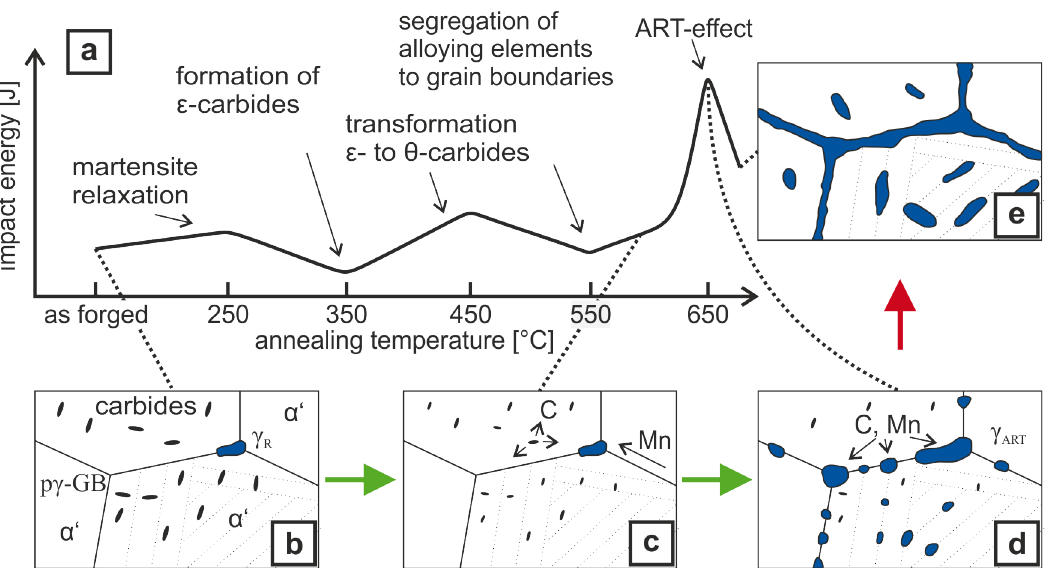
Figure 8. Correlation of the Charpy impact energy alteration [8] with austenite morphology obtained through ART annealing ( a ). The ( b – e ) describe the formation of the microstructure and are explained in detail in the text. α ’ is representing the martensitic matrix, γ is representing austenite in the retained ( γ R ) and ART-annelead ( γ ART ) condition, while p γ -GB stands for prior austenite grain